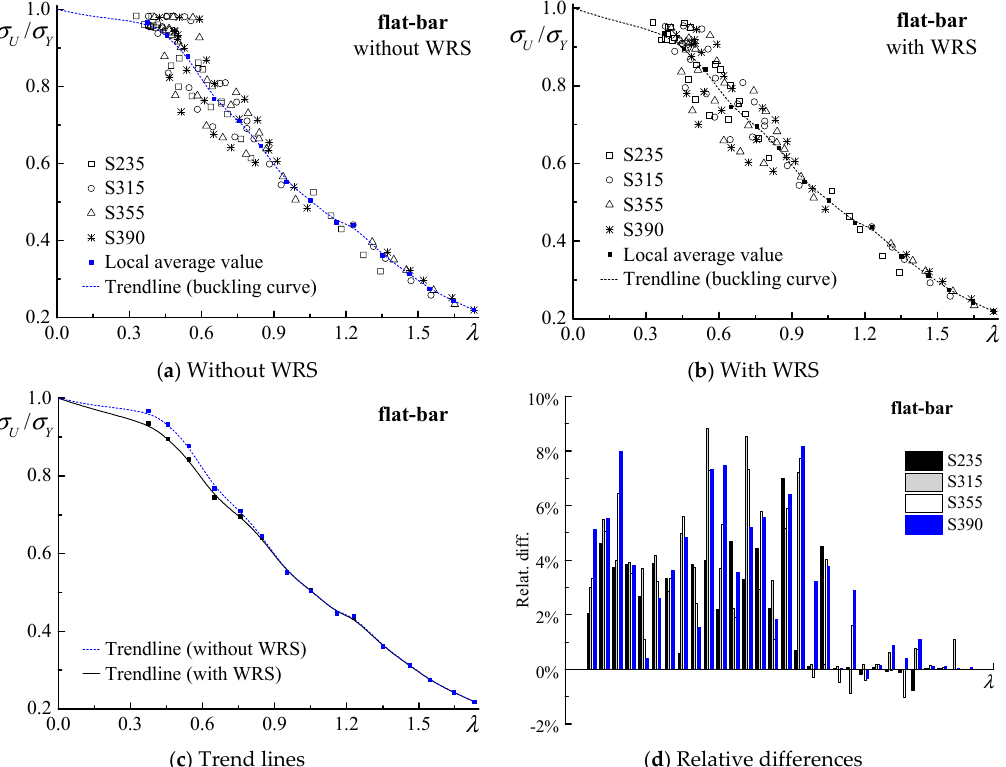
Figure 8. Ultimate strength of flat-bar stiffened plates versus column slenderness ratio. Appl. Sci. 2019 , 9 , x FOR PEER REVIEW